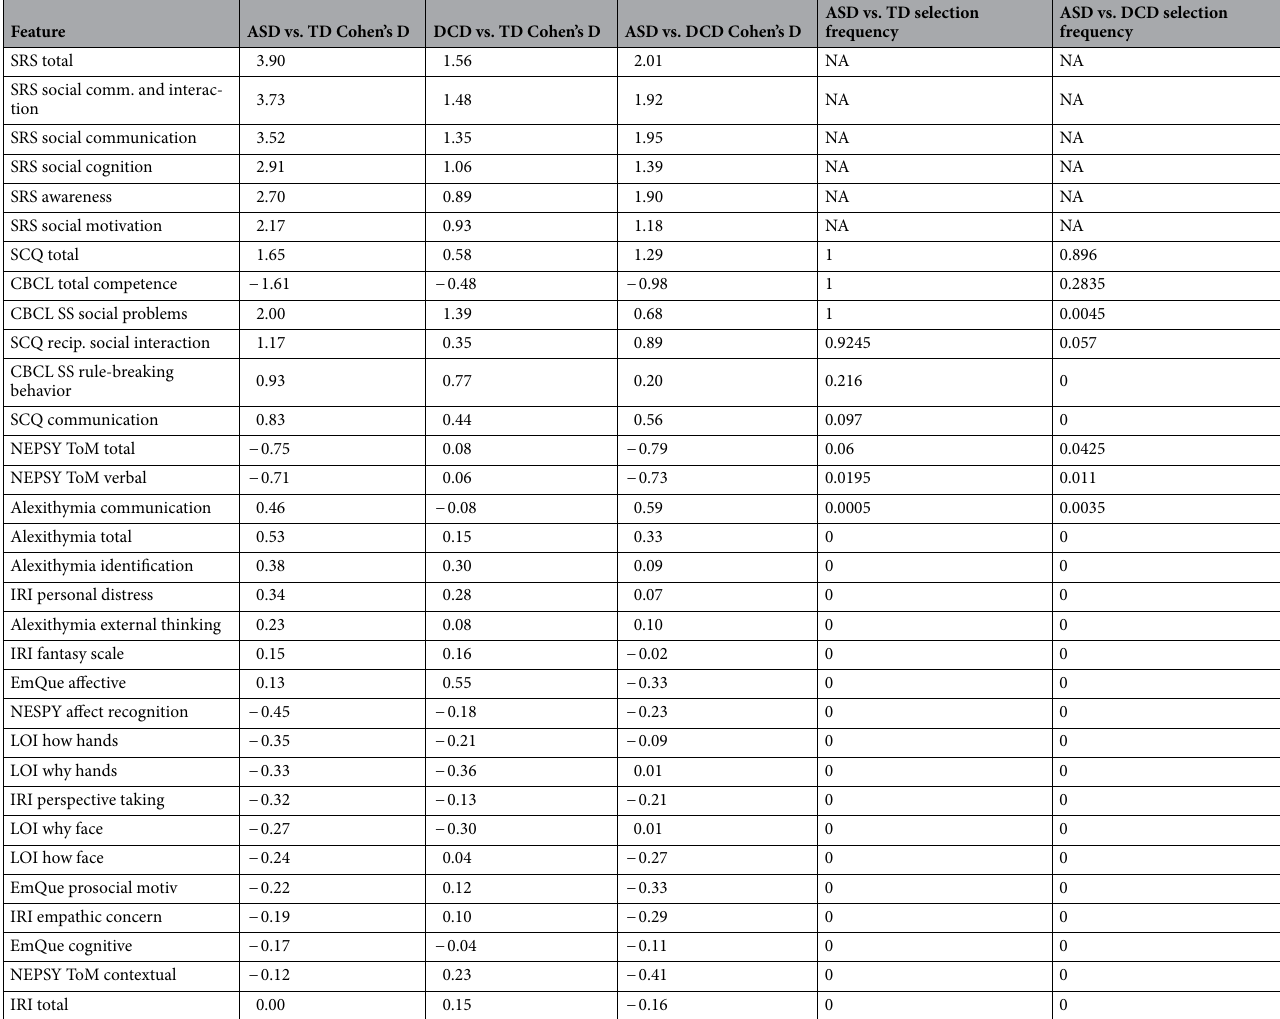
Table 3. Importance of social RDoC features in distinguishing ASD. The first three columns report Cohen’s d effect size from paired comparisons between subject groups. The last two columns report selection frequency of each feature by univariate feature selection for the full RDoC + M + S feature set across all 2000 cross validation loops for each of our two decoders (ASD vs. TD and ASD vs. DCD). Social features (rows) sorted by selection frequency. In CBCL features, SS = syndrome